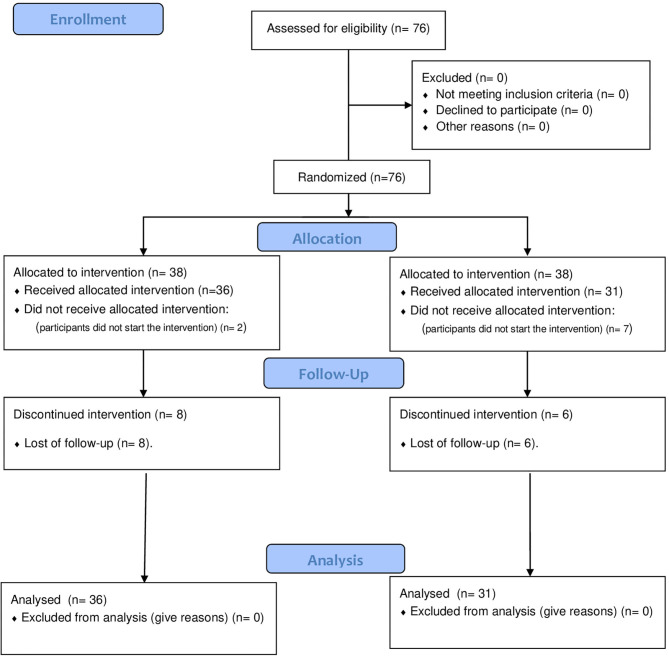
Flow chart of participants.